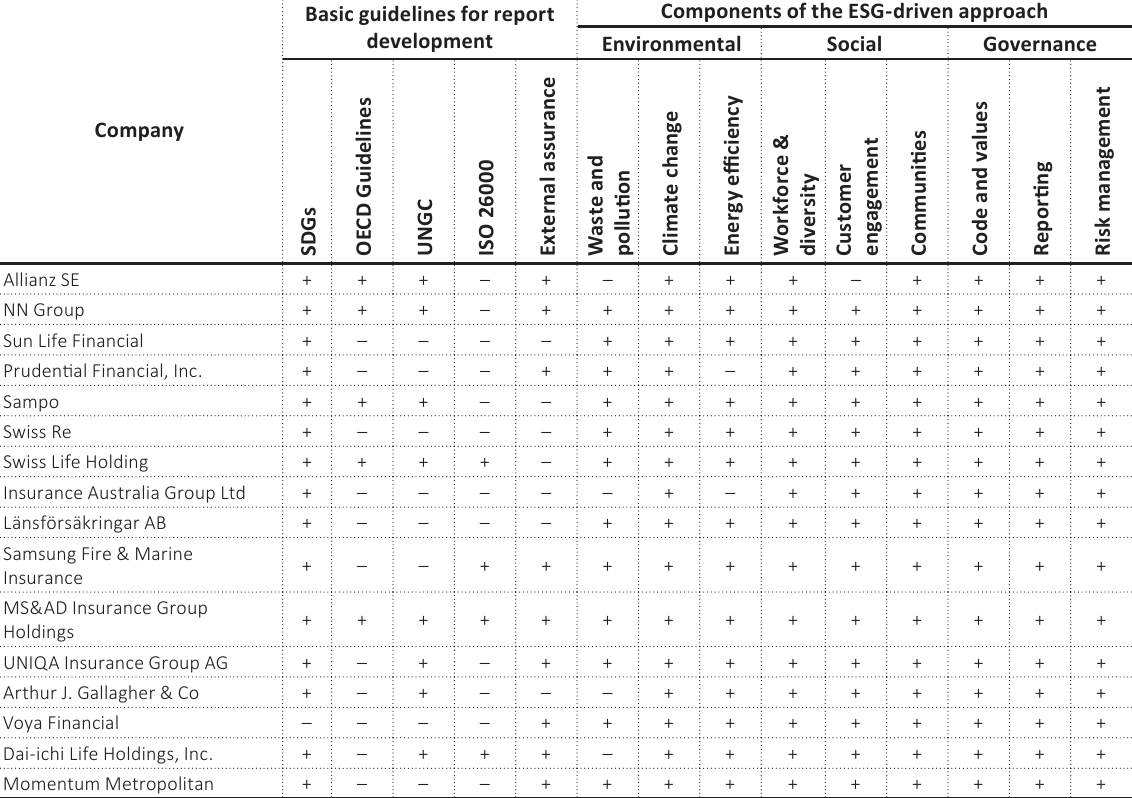
Source: Developed by the author based on the data from GRI (2020) database.